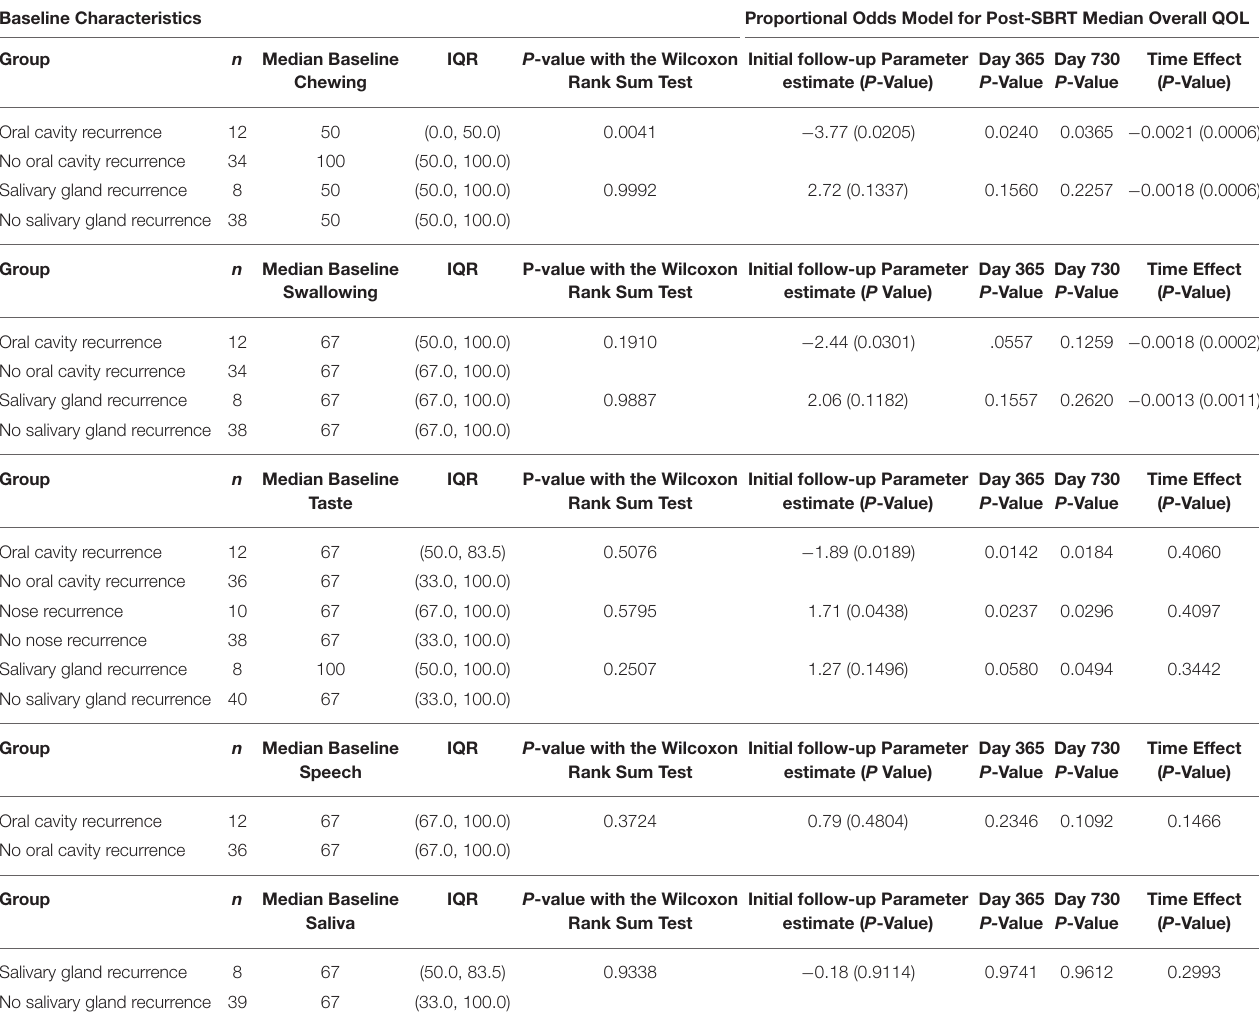
TABLE 3 | Effects of Recurrence Site on Specific QOL Domains. Baseline